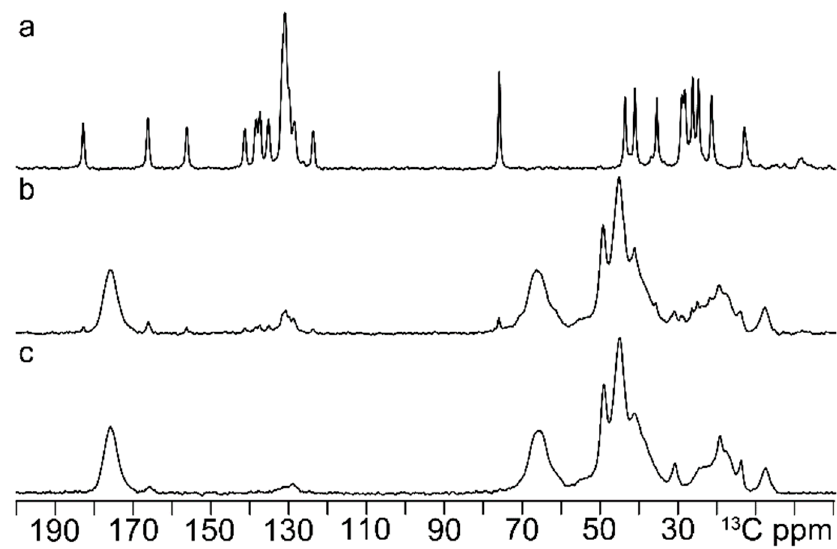
Figure 2 . Stacking plot of 13 C (150.91 MHz) CPMAS NMR spectra collected on ( a ) IRB, ( b ) polyHIPE with IRB (pre-washing) and ( c ) polyHIPE after template removal.